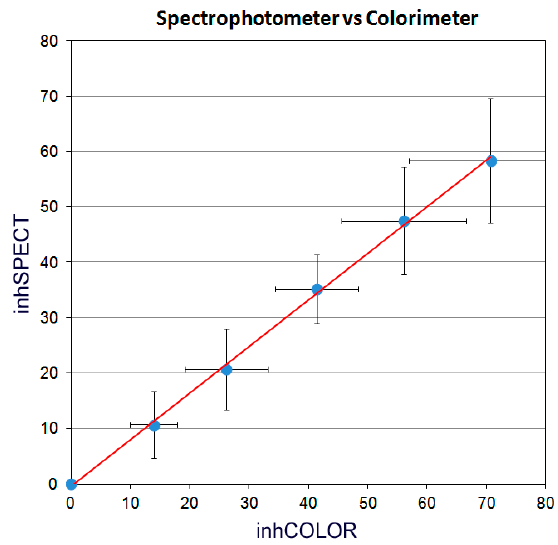
Figure 1. Comparison between the colorimeter and the Hitachi U-1900 spectrophotometer. The graph depicts the correlation between the observed RSC% (or inhibition, inh) from either the colorimeter (inhCOLOR, x axis) or the spectrophotometer (inhSPECT, y axis). The inhibition levels for each quantity are taken as averages over 17 samples measured three times each (Table 1). The error bars represent SD. The resulting equation of the regression line is inhSPECT % = inhCOLOR % X 0.8417 − 0.4789 and the R 2 measure is 0.9988.